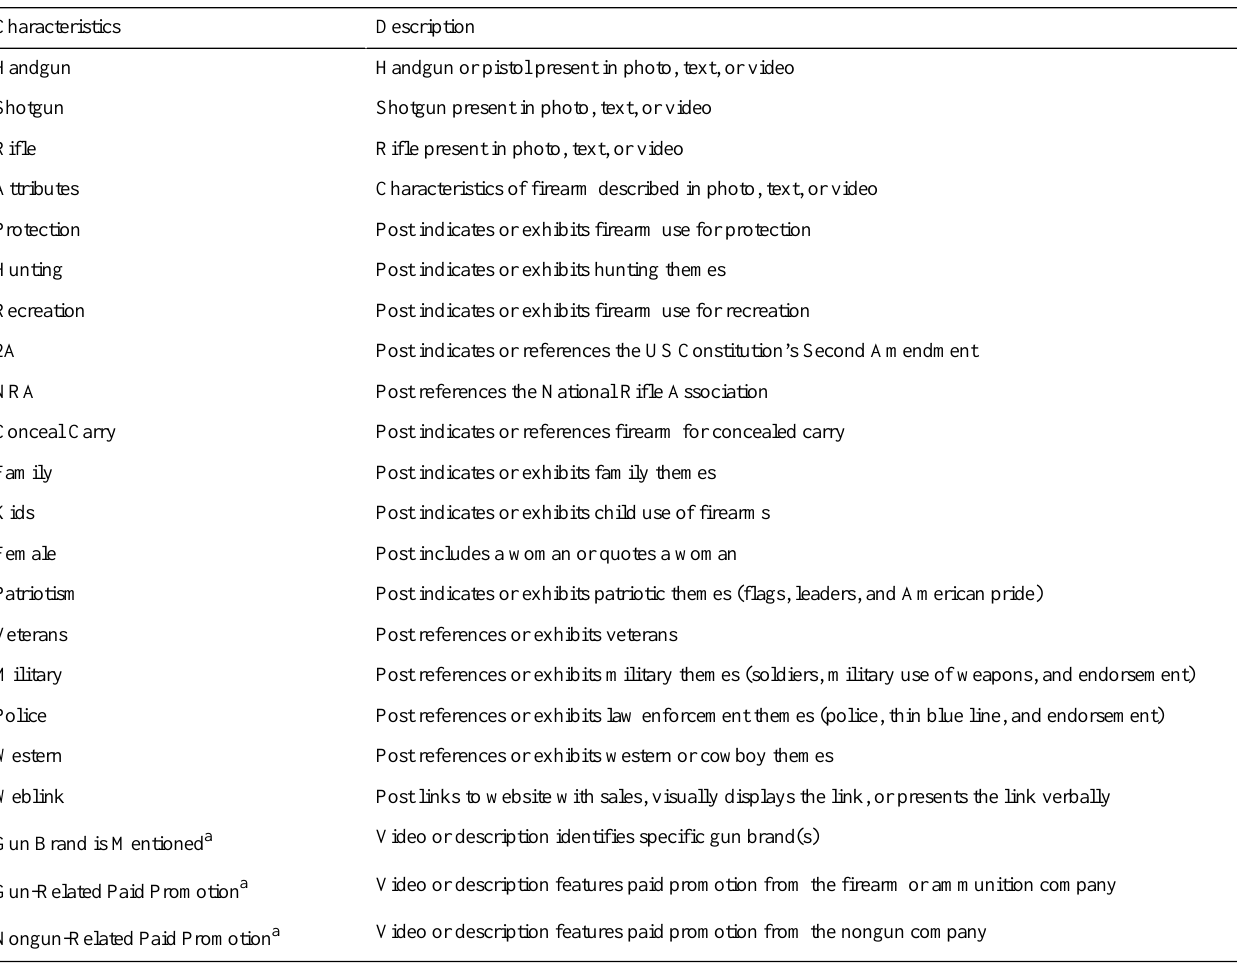
Table 5. Characteristics assessed in Twitter and YouTube activity of major firearm manufacturers and firearm influencers.